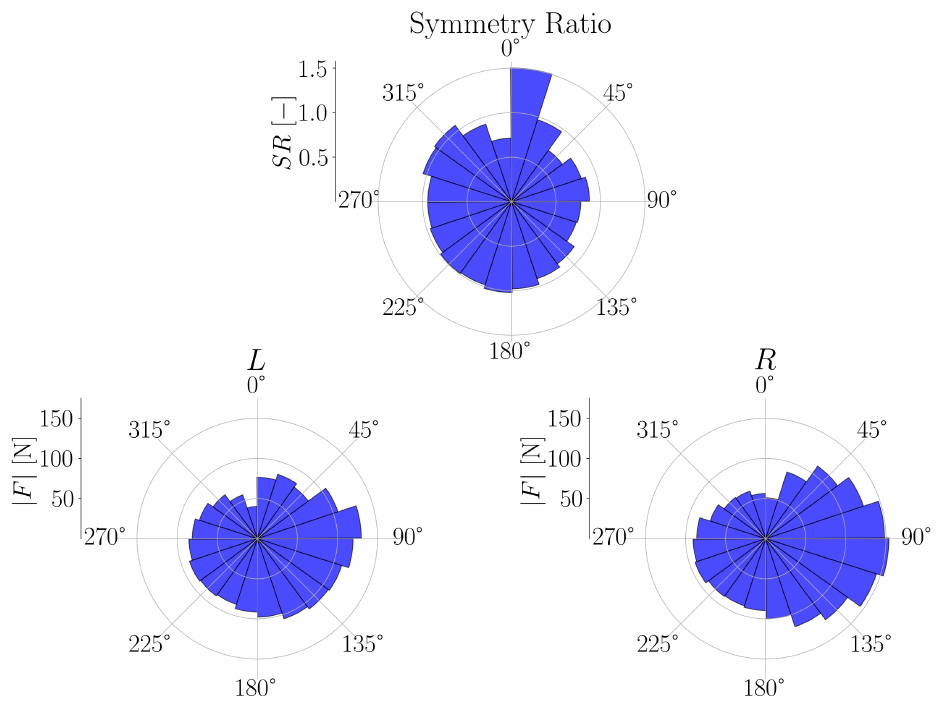
Figure 12. Pedalling force and force symmetry over crank angle. Histogram of the magnitude of force exerted on pedal as a function of the crank angle averaged out throughout the